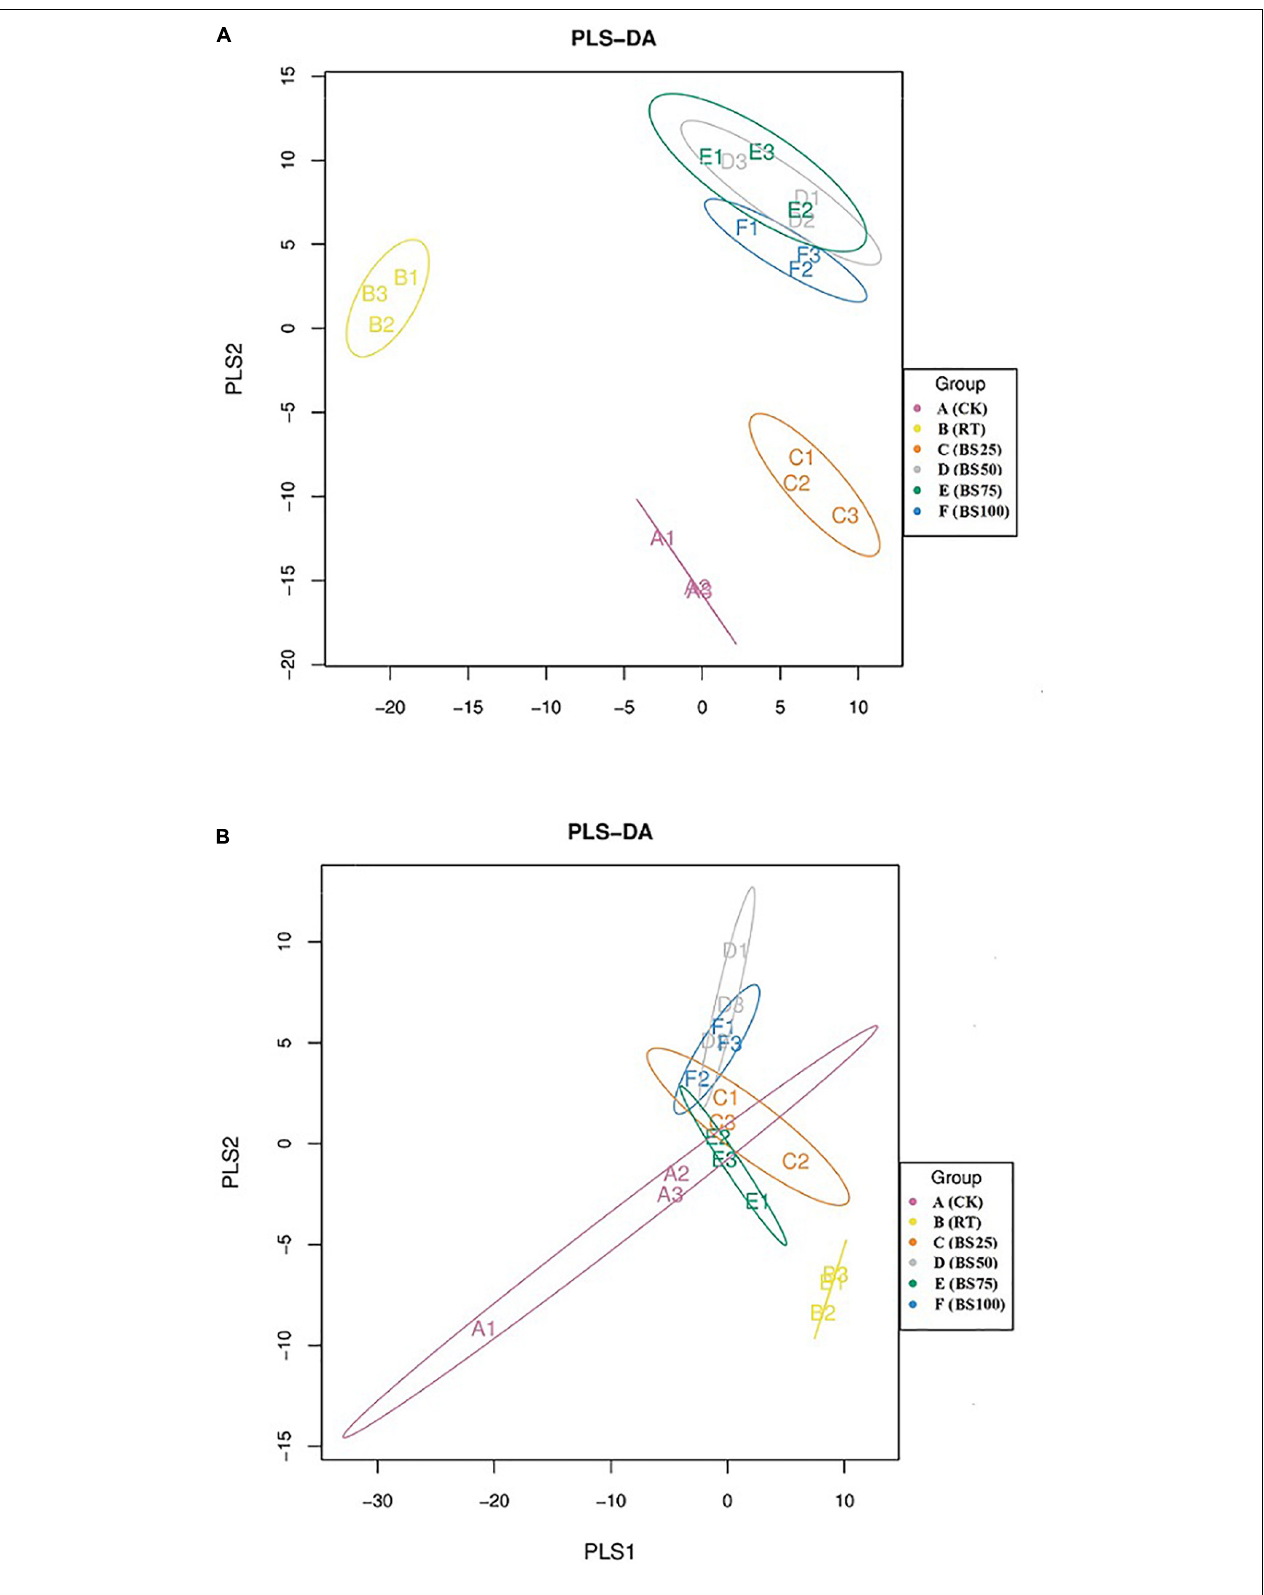
FIGURE 4 | Partial least squares discriminant analysis (PLS-DA) of the soil bacterial (A) and fungal (B) communities in different treatments.